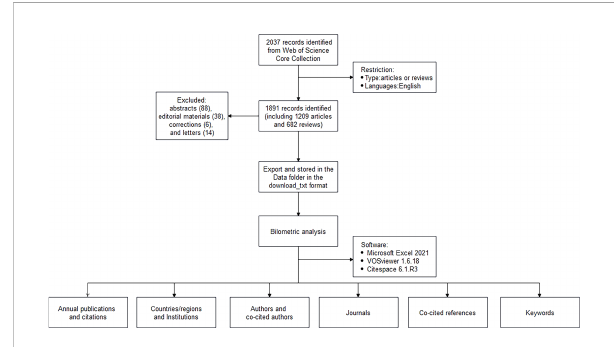
FIGURE 1 Flow chart for the analysis of the gut-liver axis in NAFLD